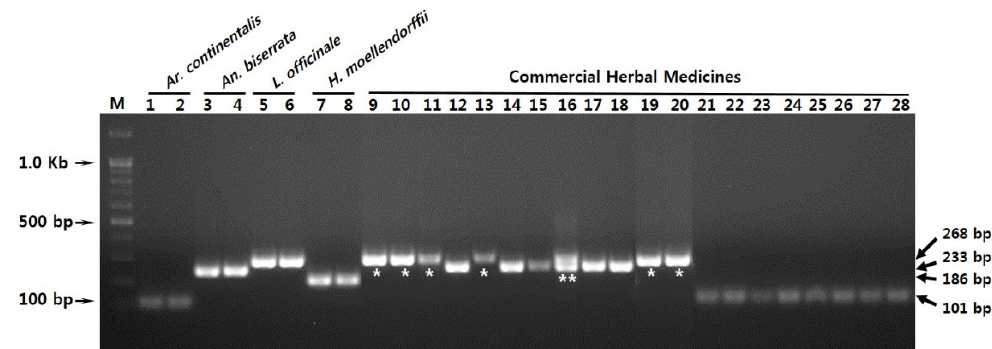
Figure 4. Analysis of commercial herbal medicine samples using the multiplex-SCAR assay. Lanes 1–8: control plant materials; Lanes 9–28: commercial herbal medicines collected from Chinese and Korean herbal markets. Sample details are provided in Supplementary Table S2. M represents a 100 bp DNA ladder. Lanes 1–28 correspond to those listed in Supplementary Table S2. Arrowheads to the right and left of the panels indicate the precise sizes of the PCR products and DNA ladder, respectively. * and ** represent the inauthentic and mixed medicinal samples against the product labels, respectively.